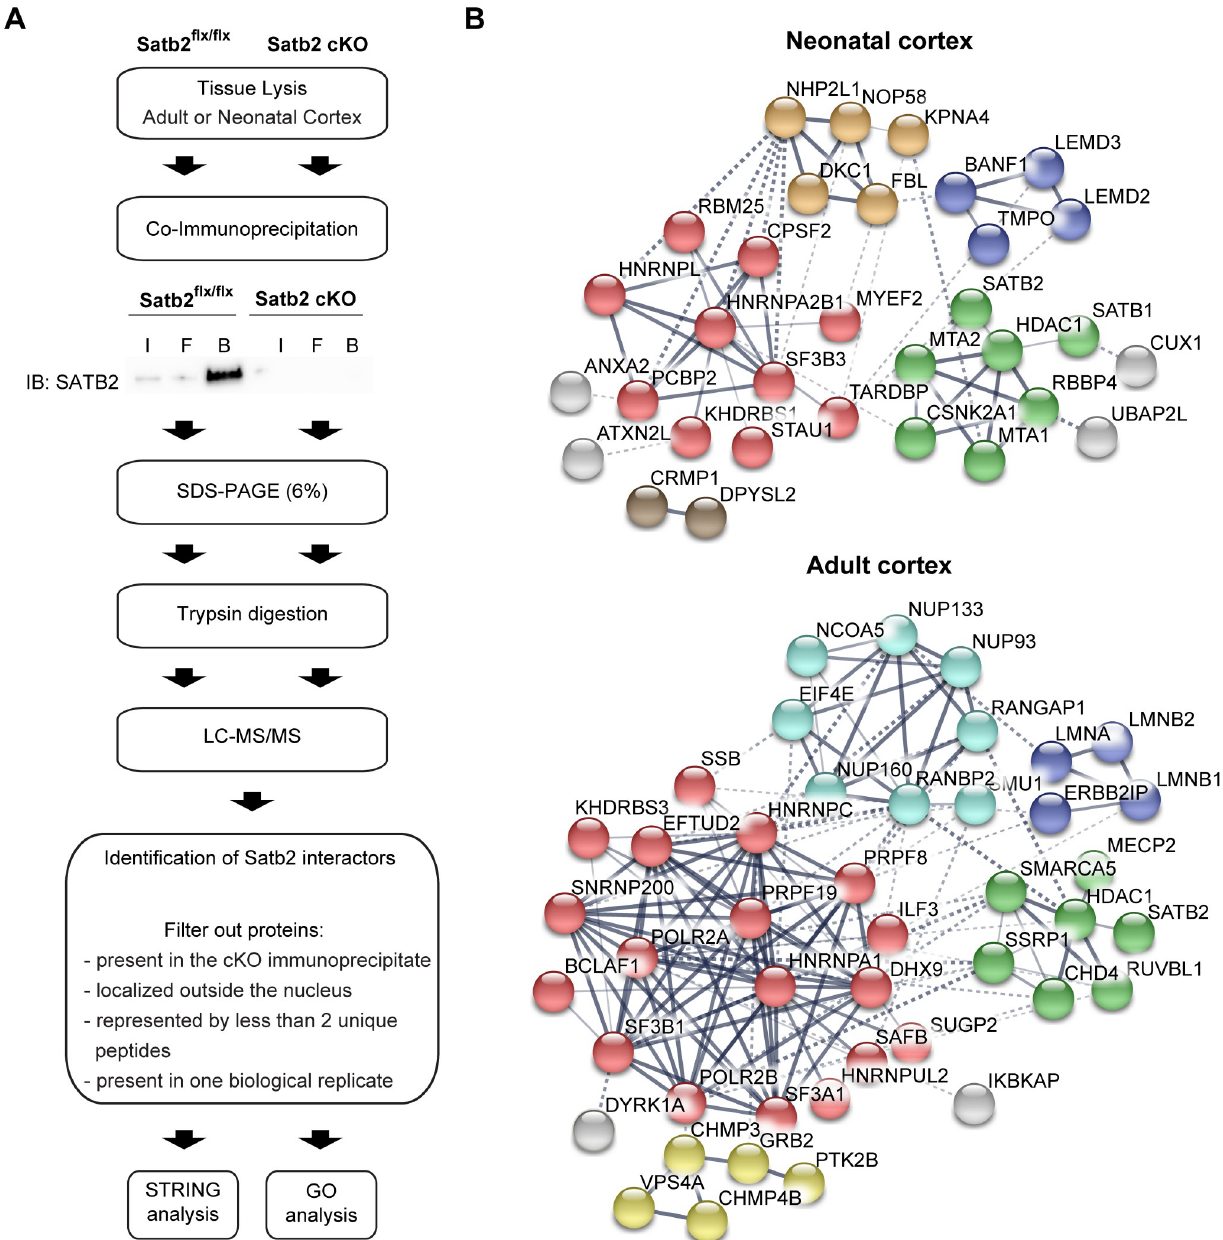
Fig 1. Proteomic analysis of SATB2 complexes in neonatal and adult mouse cortex. (A) Schematic of experimental workflow. IP were performed using cortical lysates from control ( Satb2 flx/flx ) and Satb2 cKO mice (adult cortex: Satb2 flx/flx :: CamK2a-Cre ; neonatal cortex: Satb2 flx/flx :: Nes-Cre ). (B) Protein- protein interaction networks of neonatal and adult cortex SATB2 interactomes, extracted from the STRING 10.5 database. Shown are only interactors that are connected within a network. Line thickness indicates the strength of data support. Clusters identified by k-means clustering are shown in different colors: red, RNA binding/processing proteins; green, HDAC1/NURD complex-associated proteins; dark blue, nuclear lamina-associated proteins; light blue, nuclear pore complex; yellow, ESCRTIII complex-associated proteins; orange, nucleolar proteins; brown, CRMP1- DPYSL2 cluster; grey, proteins without clearly defined